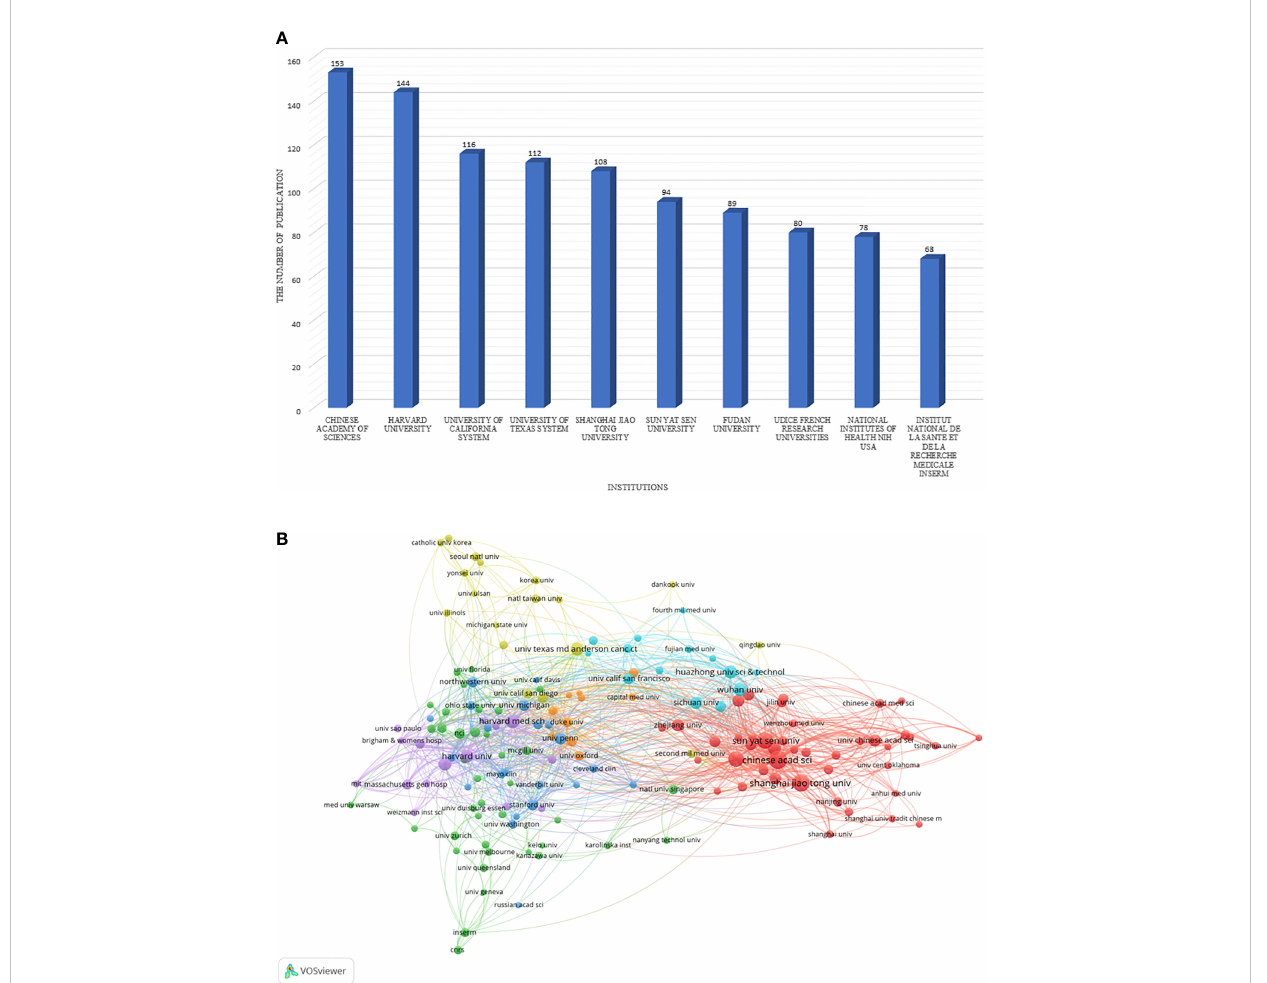
FIGURE 3 The distribution of institutions. (A) The top 10 institutions that published the largest number of articles are listed. (B) A network map showing the relations between various